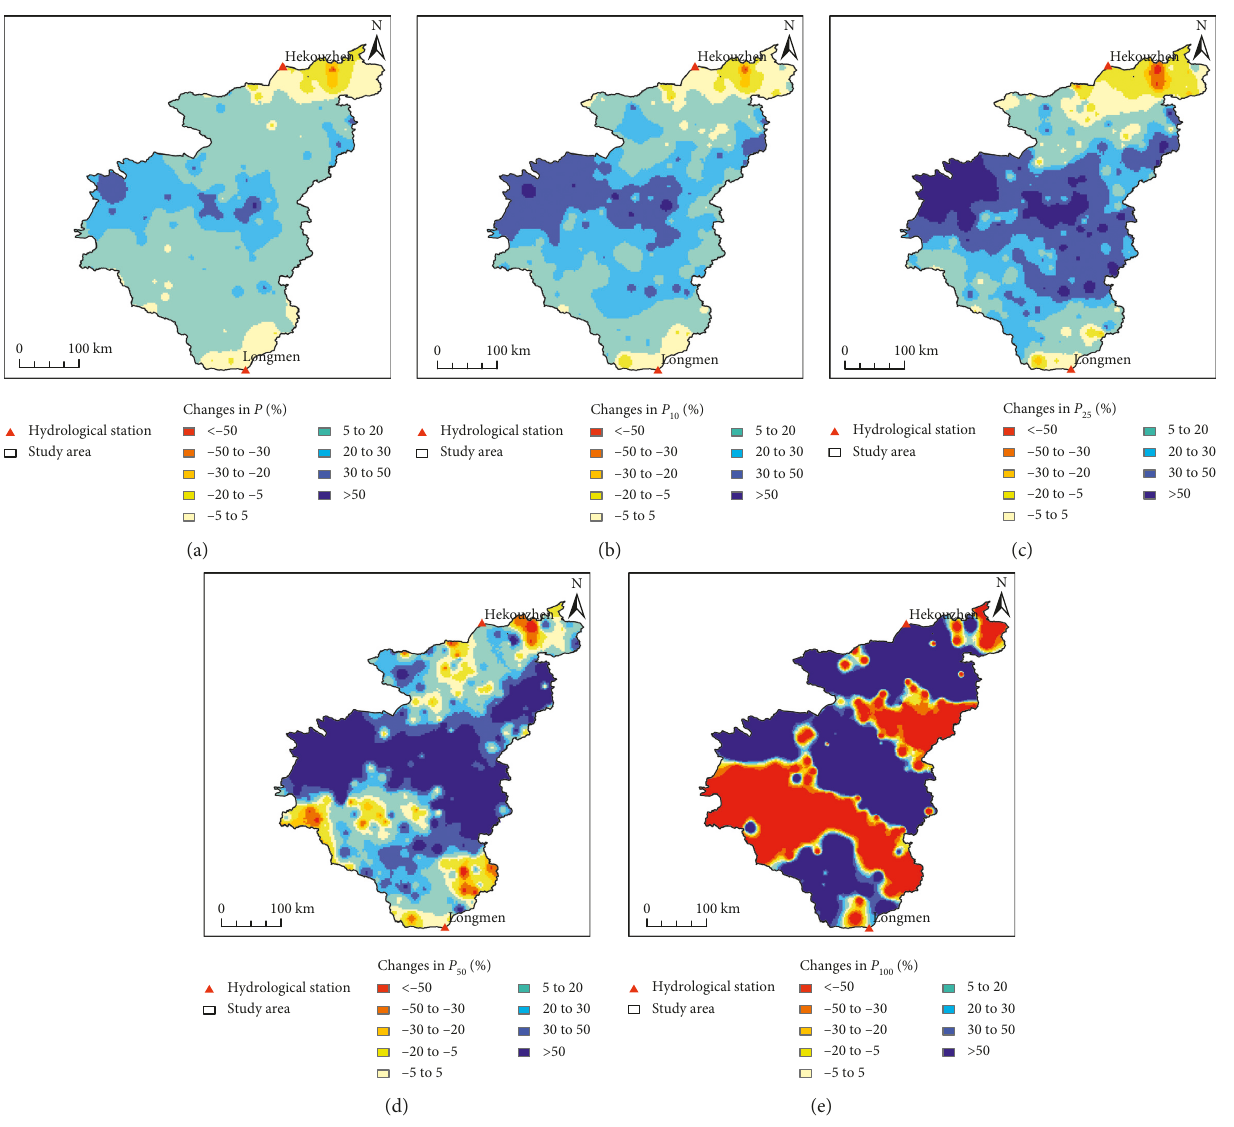
Figure 7: Spatial distribution of changes in precipitation: (a) P , (b) P with